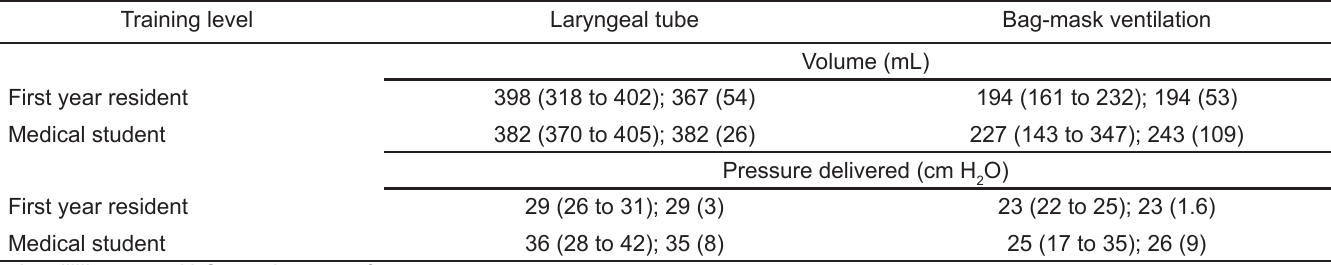
Table. Median and mean volume delivered, by training level and technique.